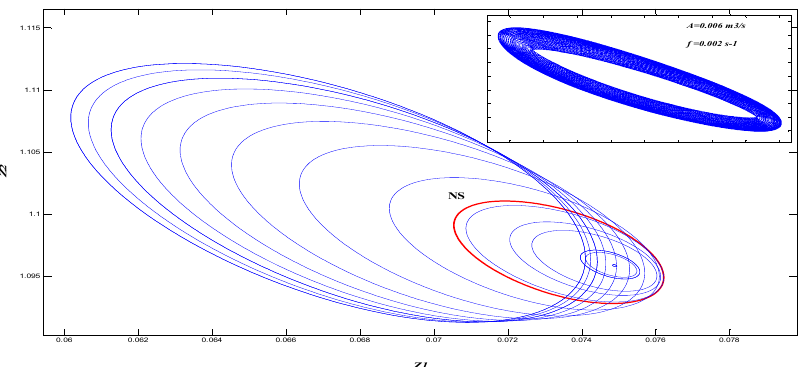
Figure 9. Continuation of limit cycle with forcing amplitude as bifurcation parameter.